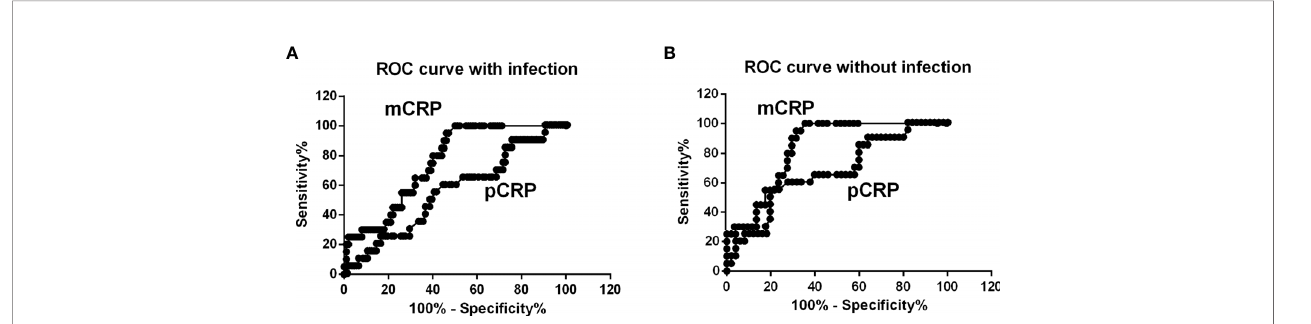
FIGURE 3 | ROC curve analysis. (A) ROC curves were analyzed to determine diagnostic value of plasma mCRP level for distinguishing AOSD patients from those with RA, PMR, and infection. The area under the curve for mCRP was 0.76 (95% CI, 0.66 to 0.85) ( P = 0.0003). (B) ROC curve analysis with exclusion of infection patients. For the diagnostic value of plasma mCRP level for distinguishing AOSD patients from those with RA or PMR and controls, the area under the curve for mCRP was 0.83 (95% CI, 0.74 to 0.92) ( P < 0.0001). To determine the cut-off value, the point on the ROC curve with the minimum distance from the left-upper corner of the unit square was